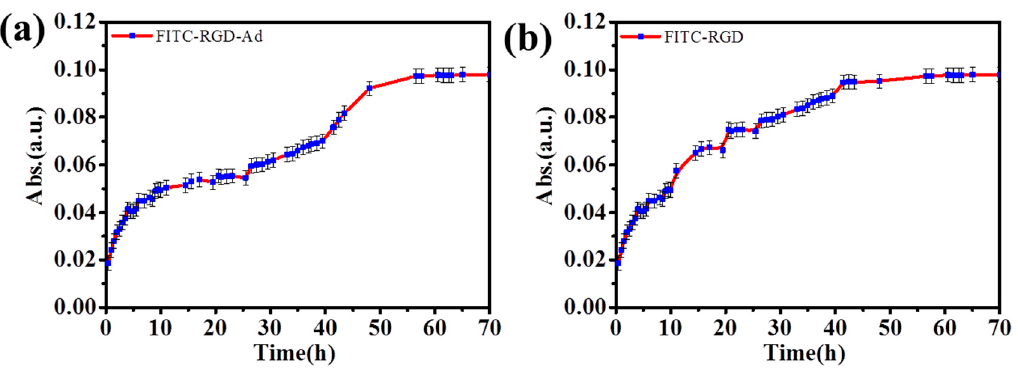
Figure 8. The release curves of ( a ) FITC–RGD and ( b ) FITC–RGD–Ad from (PAH/SiO 2 ) 1 /(PAH/HA–CD) 40 /(PAH/SiO 2 ) 1 /(PAH/HA–CD) 40 laminated multilayer films.